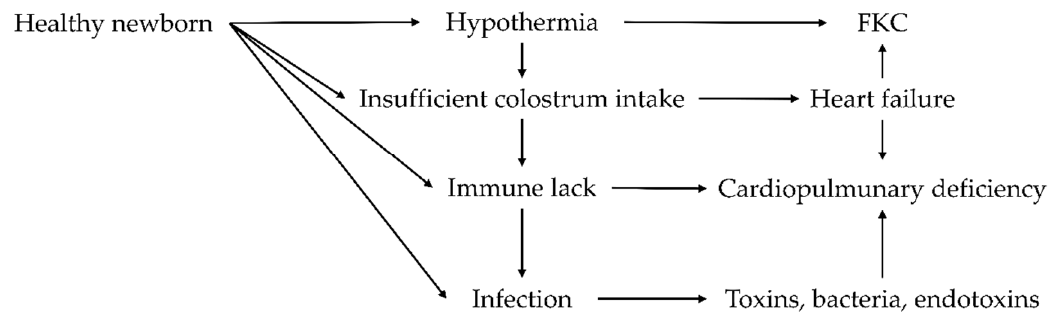
Figure 1. Causes and interactions of Fading Kitten Complex (FKC) or Fading Puppy Complex (FPC) [92,93] .